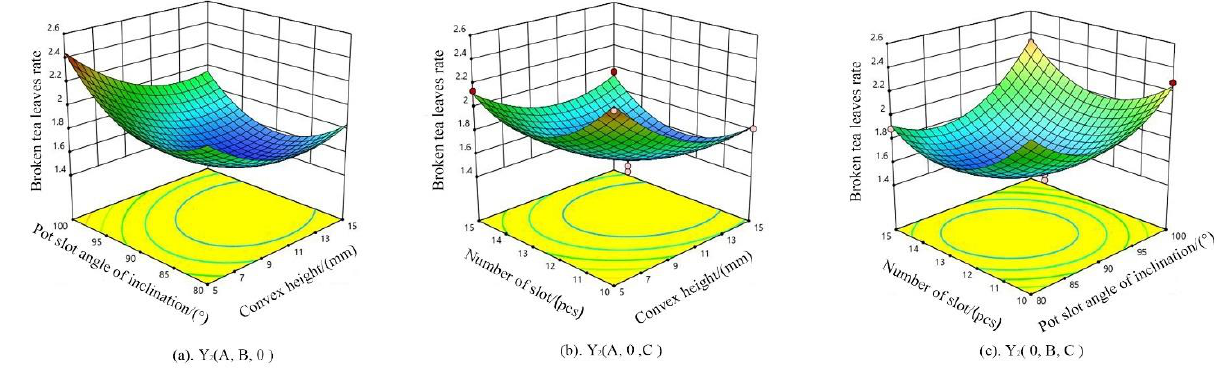
Figure 16. Response surface analysis of influencing factors of broken tea leaf rate.